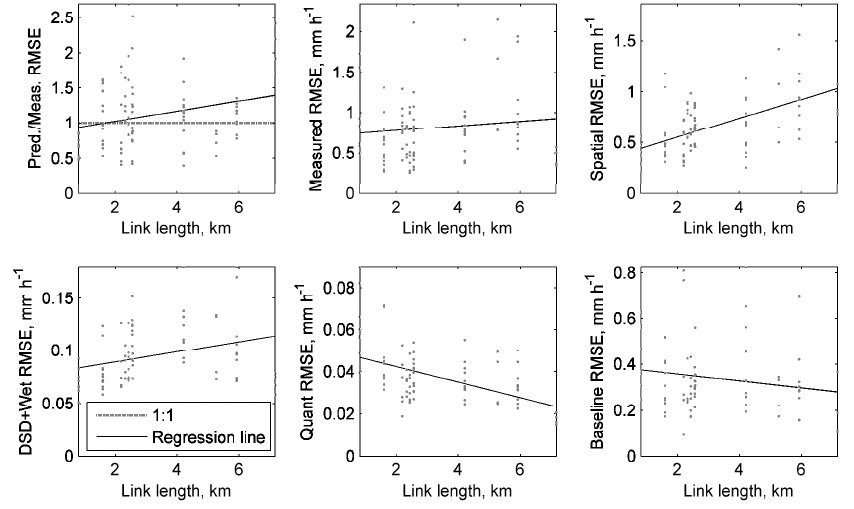
Fig. 11. Performance statistics S j , j = 1,.., 96 (Eq. 50) for total predicted error, measured errors and various error sources (spatial variability, DSD and wet antenna, quantization and baseline), as a function of link length, ∆ t = 60 minutes.